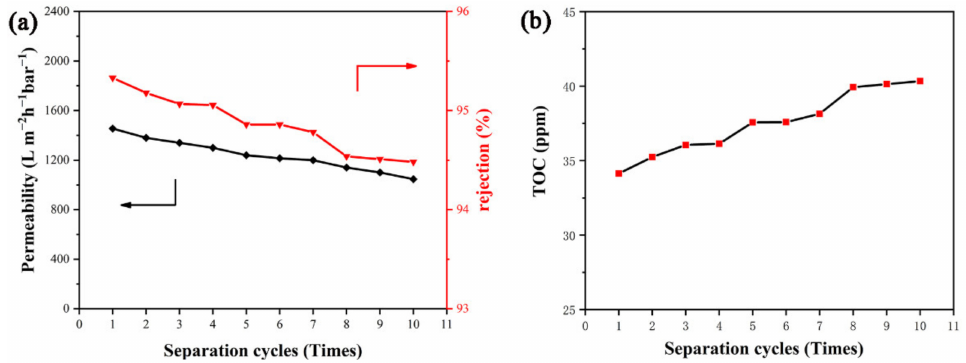
Figure 11. The relationship curves of permeability and rejection ( a ) and TOC ( b ) versus separation cycles of PDA@PAN nanofibrous membrane for n-dodecane/water